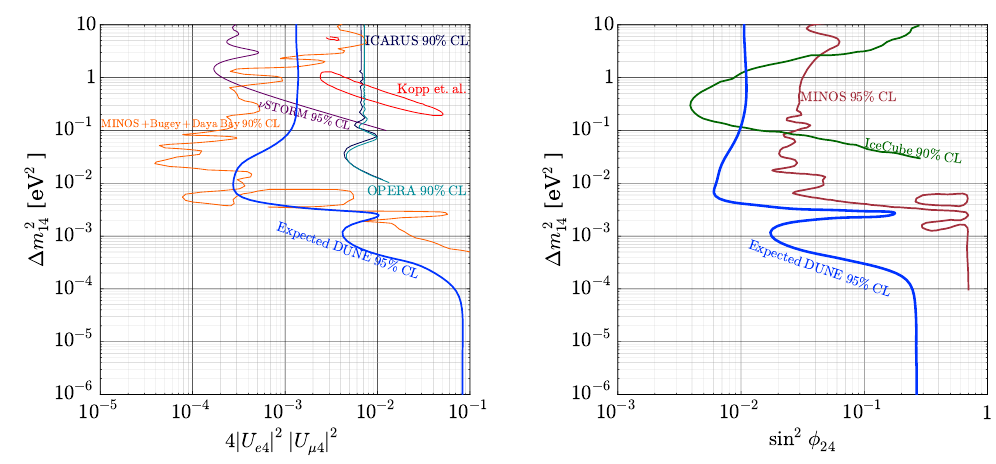
Figure 11.1: Sensitivity of the DUNE experiment to the fourth neutrino hypothesis, updated from [ 256 ] . See [ 256 ] for details. ∆ m 2 ≡ | U | 2 panel, sin 2 θ µ 4 24